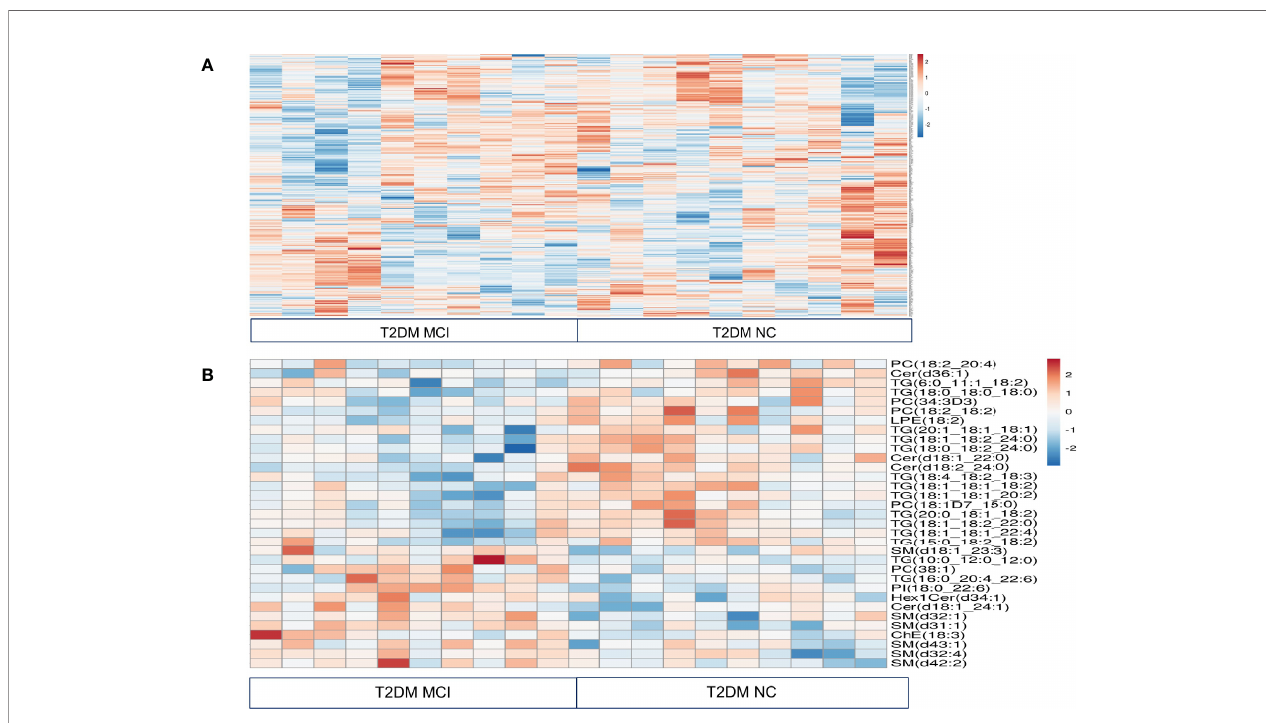
FIGURE 1 | Relative quantitation of different lipids in the serum of type 2 diabetes mellitus patients with mild cognitive impairment (MCI) versus normal cognition (NC) using untargeted lipidomic analysis were presented in a heat map (A) . This analysis identi fi ed a total of 646 lipids in different classes. Comparison of fold change in the log 2 transformed values of T2DM NC patients with MCI patients identi fi ed signi fi cant changes in 14 species of triacylglycerols, 11 species of sphingolipids, 5 species of phosphatidylcholine, one species each of phosphatidylethanolamine, phosphatidylinositol, and cholesterol ester. These results were visualized in a heat map (B)